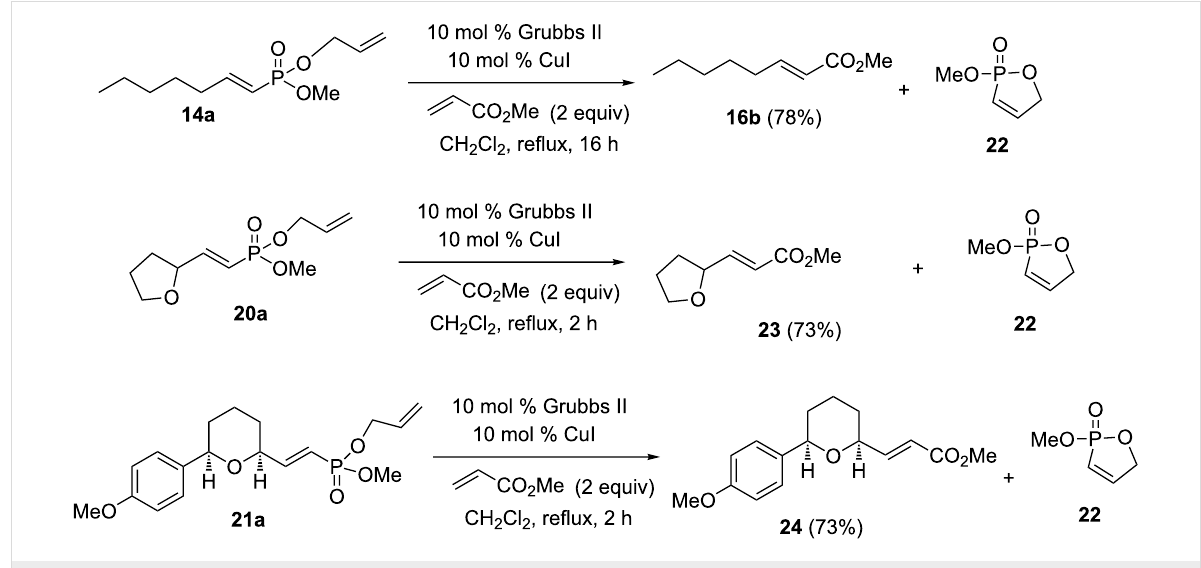
Scheme 6: Relay cross metathesis of mono-allyl vinylphosphonates with methyl acrylate.